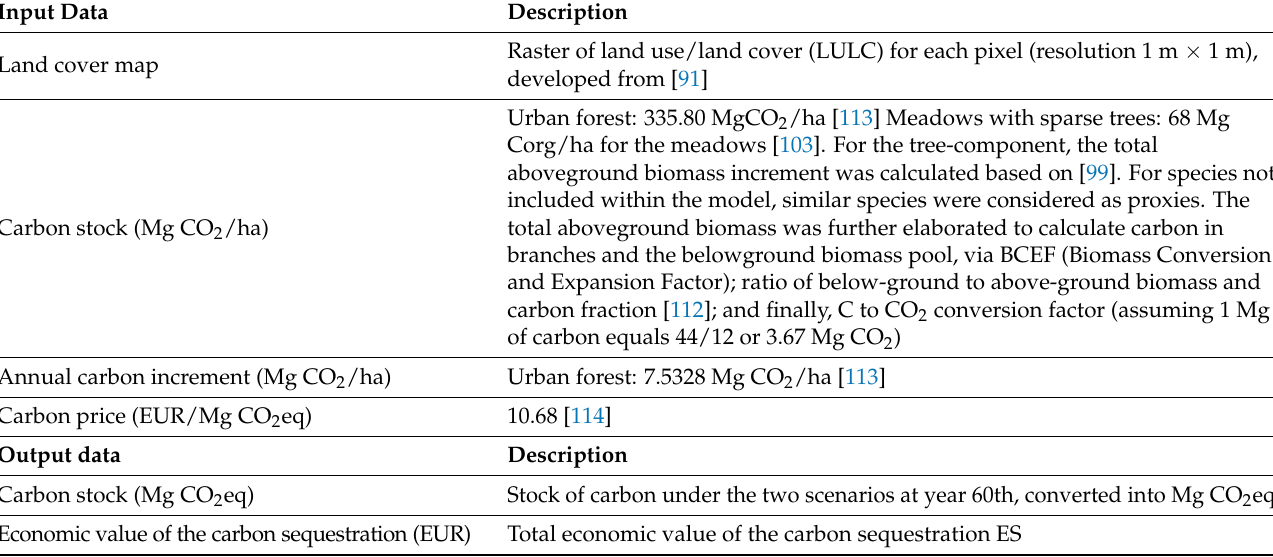
Table 9. Input and output data for the assessment and evaluation of carbon